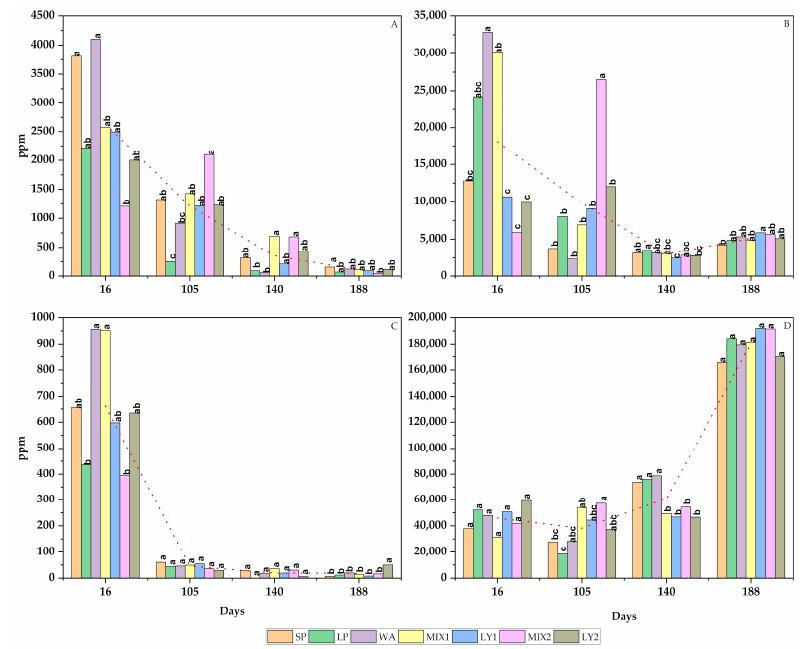
Figure 3. Lactic acid ( A ), acetic acid ( B ) and pyruvic acid ( C ) and ethanol ( D ) values in the brines during fermentations. The data are expressed as averages of triplicate measurements. Significant differences (LSD) are indicated by different letters ( p ≤ 0.05). The red dotted line represents the av- erage values at each sampling time.